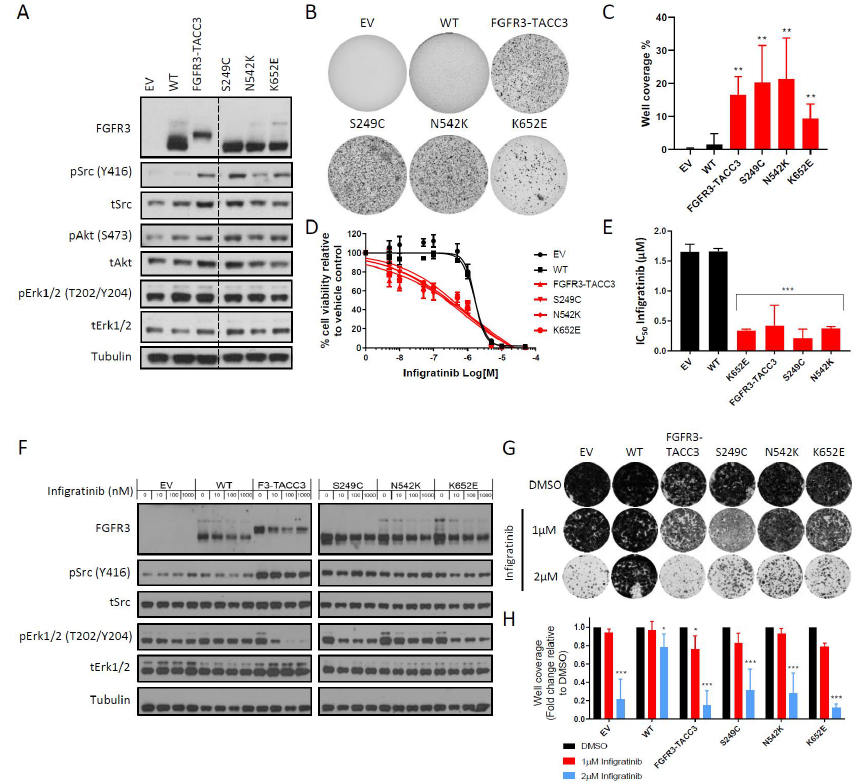
Figure 1. Cells bearing FGFR3 molecular alterations harbour intrinsic resistance to infigratinib. ( A ) Immunoblot of downstream cellular signalling pathways upon expression of FGFR3 constructs in NIH-3T3 cells is shown. ( B ) Representative images of the panel of NIH-3T3 cells in anchorage-independent soft agar assays. ( C ) Bar plots showing the quantification of well coverage of soft agar assay in panel B ( n = 6). Statistical analysis of FGFR3 mutants and fusion versus WT FGFR3 was performed by one-way ANOVA with Dunnett’s post-hoc multiple comparison adjusted p -value (** p < 0.01). ( D ) Dose-response curves of the panel of NIH-3T3 cell lines upon treatment with infigratinib for 72 h. Cell viability is normalised to DMSO control treatment ( n = 3). ( E ) Bar plots showing IC 50 values of infigratinib calculated from dose response curves in ( D ). Statistical analysis of FGFR3 mutations and fusion versus WT FGFR3 was performed by one-way ANOVA with Dunnett’s post-hoc multiple comparison adjusted p -value (*** p < 0.001). ( F ) Immunoblot of Erk1 / 2 and Src phosphorylation levels in NIH-3T3 cells treated with infigratinib at the indicated doses for 6 h is shown. ( G ) Representative images of long term colony formation assay in the NIH-3T3 cell line panel upon treatment with infigratinib or DMSO control at the indicated doses for 2 weeks. ( H ) Bar plots showing the quantification of well coverage of the colony formation assay in panel G. Data for each cell line are normalised to DMSO control treatment ( n = 3). Statistical analysis of drug treatment versus DMSO was performed by paired two-way ANOVA with Dunnett’s post-hoc multiple comparison adjusted p -value (* p < 0.05, *** p < 0.001). Data presented for ( C ), ( D ), ( E ) and ( H ) represent mean ± SD. EV – empty vector control, WT – wildtype FGFR3, F3-TACC3 –